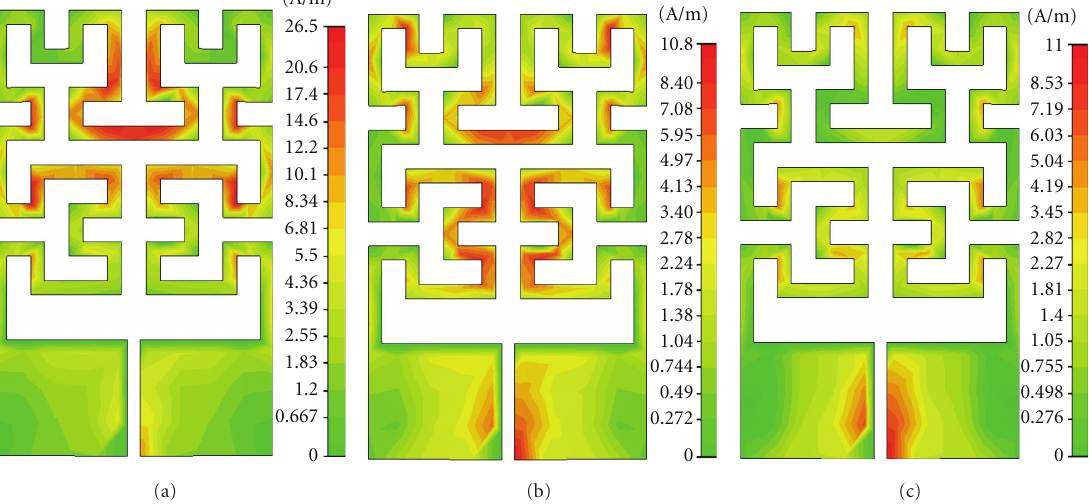
Figure 7: Surface current distribution of the proposed antenna at resonance frequencies. (a) 2.45 GHz, (b) 3.35GHz, and (c) 5.5 GHz.